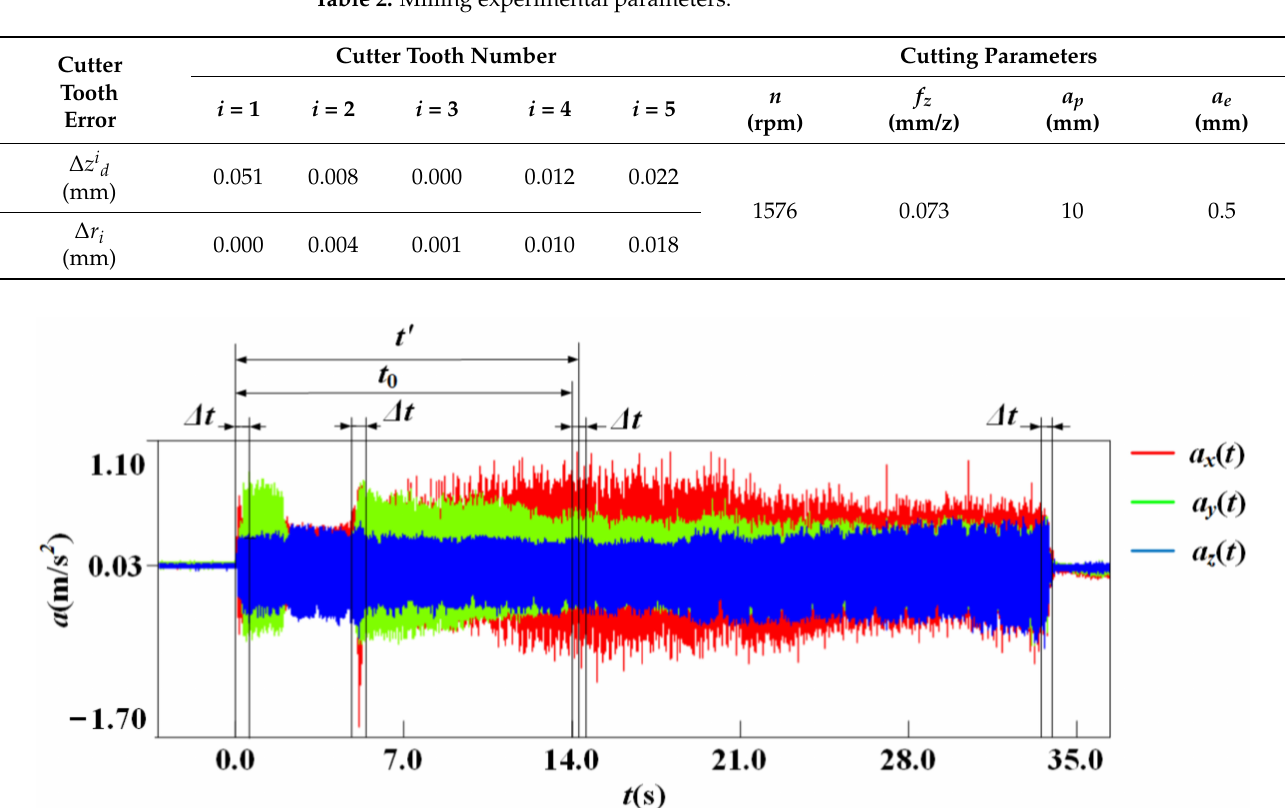
Table 2. Milling experimental parameters.